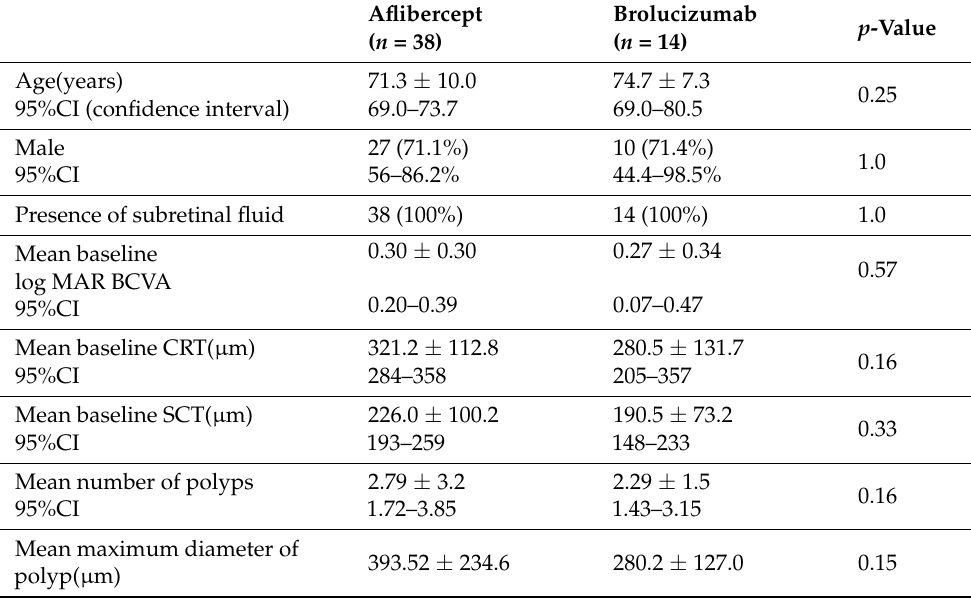
Table 1. Baseline demographic and clinical characteristics of patients with polypoidal choroidal vasculopathy between two